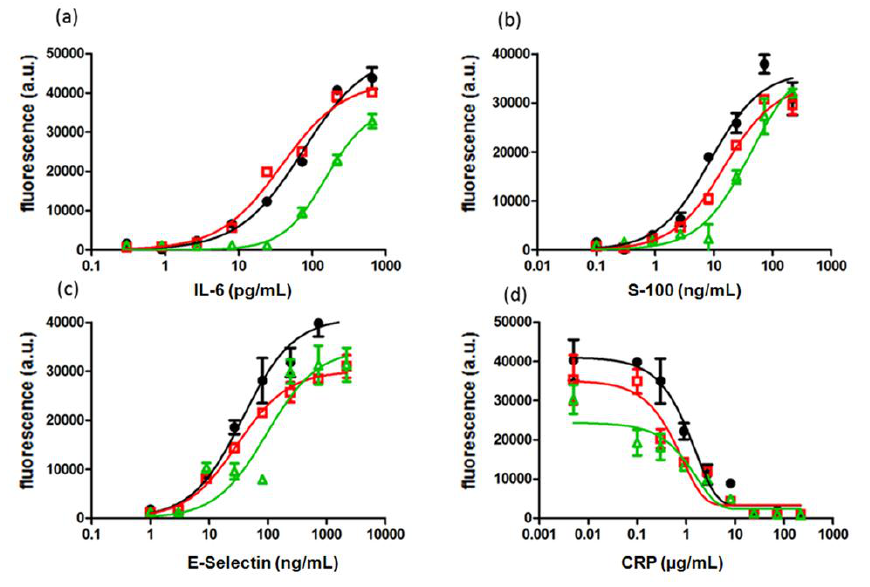
Figure 3. Calibration curves for ( a ) IL-6 ( b ) S-100 ( c ) E-Selectin and ( d ) CRP in human serum 1:10 diluted with assay buffer after 2.5 h ( ), 2 ( ) and 1.5 h ( ) processing